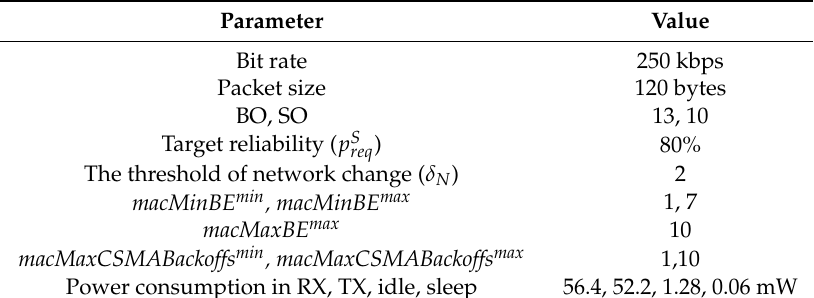
Table 2. Parameters for simulation. BO—beacon order; SO—superframe order; RX—Receiving;